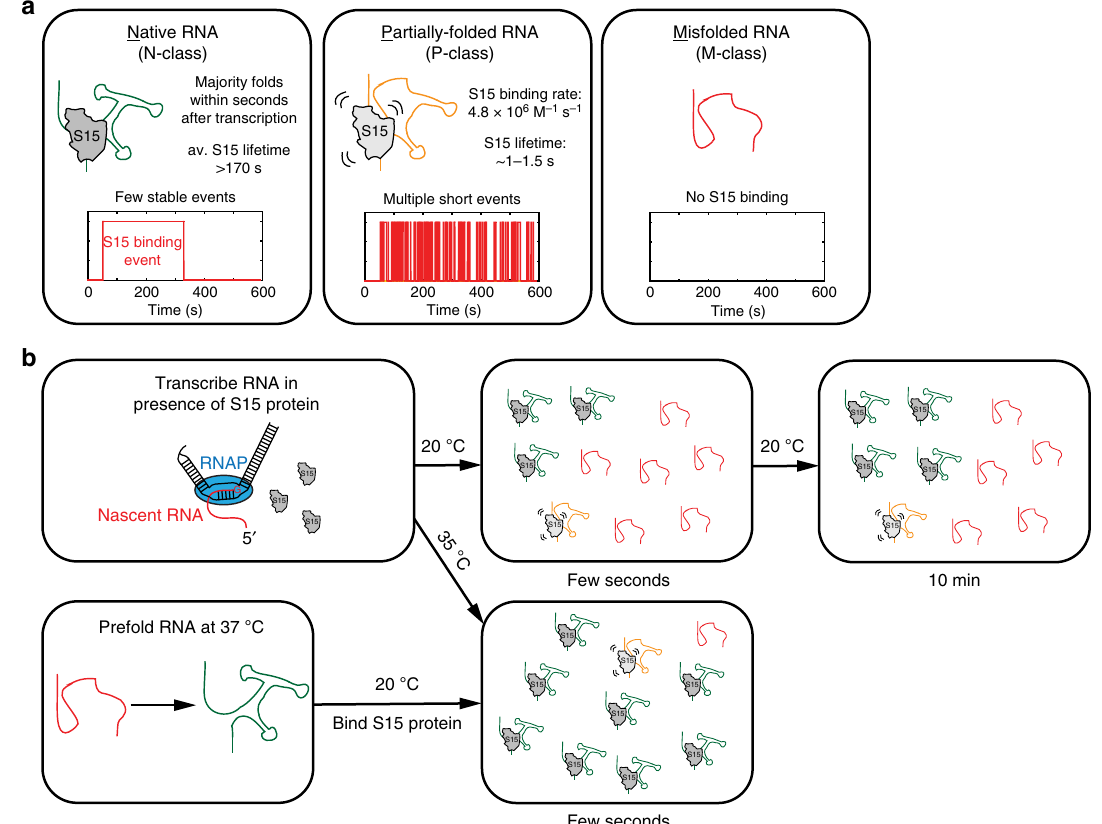
Fig. 7 Model for S15 binding to nascent versus pre-folded RNA. a Kinetic characterization of different RNA folding classes. b Schematic of S15 binding to nascent versus pre-folded 3-way junction